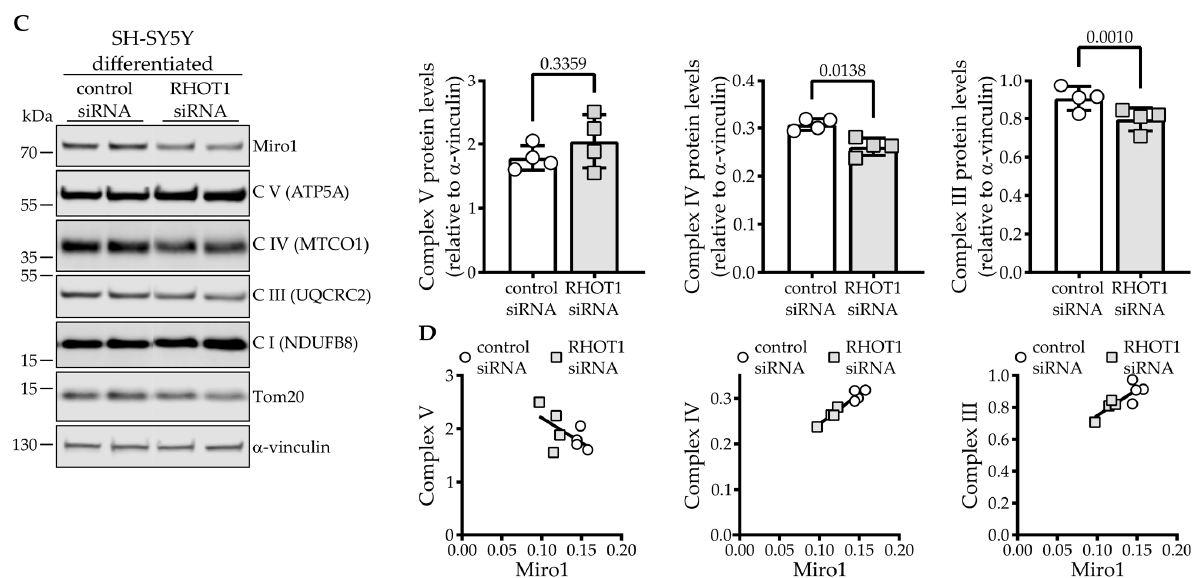
Figure 4. The S156A mutation reduces Miro1 protein levels affecting OXPHOS in postmitotic dif- ferentiated cells. ( A ) Representative Western blot showing Miro1, Tom20, complex V/IV/III/I in NPCs. Quantification of intensity of Miro1, complex V and III bands normalized to α -vinculin. Error bars depict standard deviation (n = 4); Miro1: Wilcoxon test matched pairs signed rank test; complexes V and III: paired t test, two-tailed. ( B ) RHOT1 knockdown in undifferentiated SH-SY5Y cells. Representative Western blot showing Miro1, Tom20, complex V/IV/III/II/I in undifferentiated SH-SY5Y cells transfected with RHOT1 or non-targeting siRNA. Quantification of intensity of com- plex V and III bands normalized to α -vinculin. Error bars depict standard deviation (n = 3); complex V: Wilcoxon test matched pairs signed rank test.; complex III: paired t test, two-tailed. ( C ) RHOT1 knockdown in differentiated SH-SY5Y cells. Representative Western blot showing Miro1, Tom20, complex V/IV/III/I in differentiated SH-SY5Y cells transfected with RHOT1 or non-targeting siRNA. Quantification of intensity of complex V/IV/III bands normalized to α -vinculin. Error bars depict standard deviation (n = 4); paired t test, two-tailed. ( D ) Correlation of Miro1 protein levels to complex V/IV/III protein levels in differentiated SH-SY5Y cells (n =